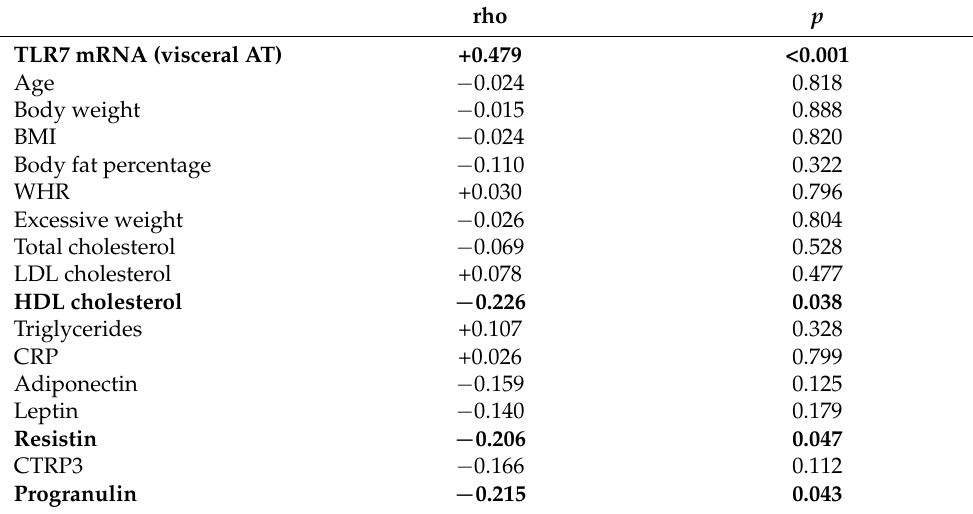
Table A1. Correlation analysis of TLR7 mRNA expression in subcutaneous adipose tissue with clinical and anthropometric parameters and with systemic adipokine levels. n = 95 obese, non- diabetic patients (14 men, 81 women). Correlation analysis was done by using the Spearman-rho test, and the respective Spearman rho and p -values are given. The bold in the table marks statistically significant